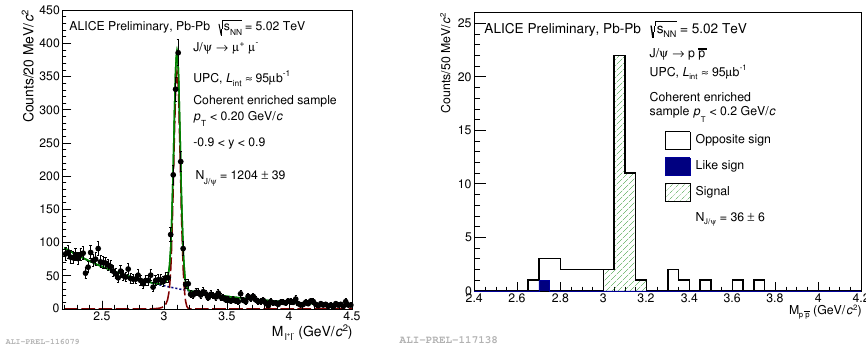
Figure 7. Invariant mass distribution for unlike-sign dimuons (left) and diprotons (right) with pair p T < 0 . 2 GeV / c and rapidity | y | < 0 . 9 in ultra-peripheral Pb–Pb collisions at